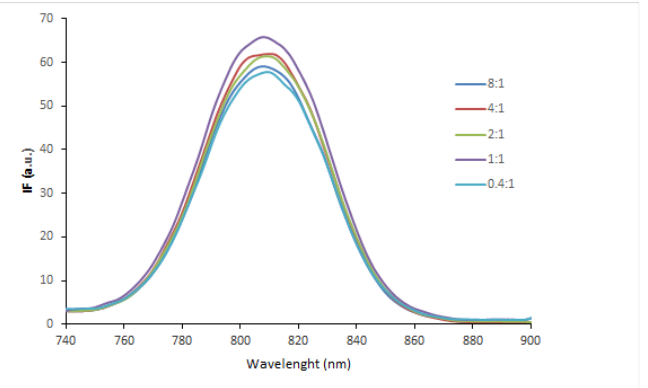
Figure 7. Fluorescence spectra of ICG after interaction with NPs at different ICG:CS molar ratios in cell culture